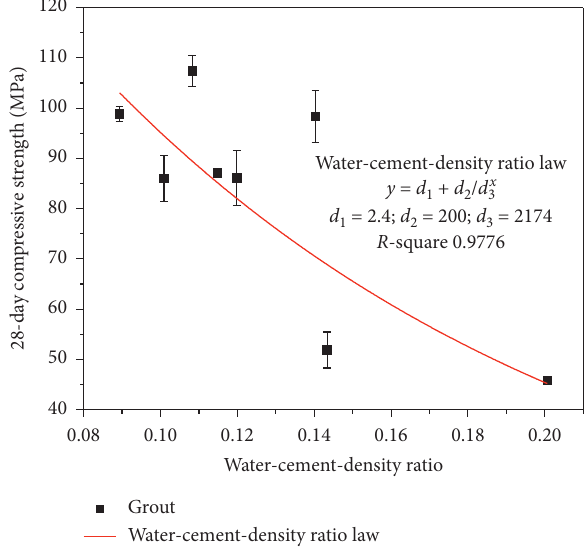
Figure 2: Simulation of water-cement-density ratio law for